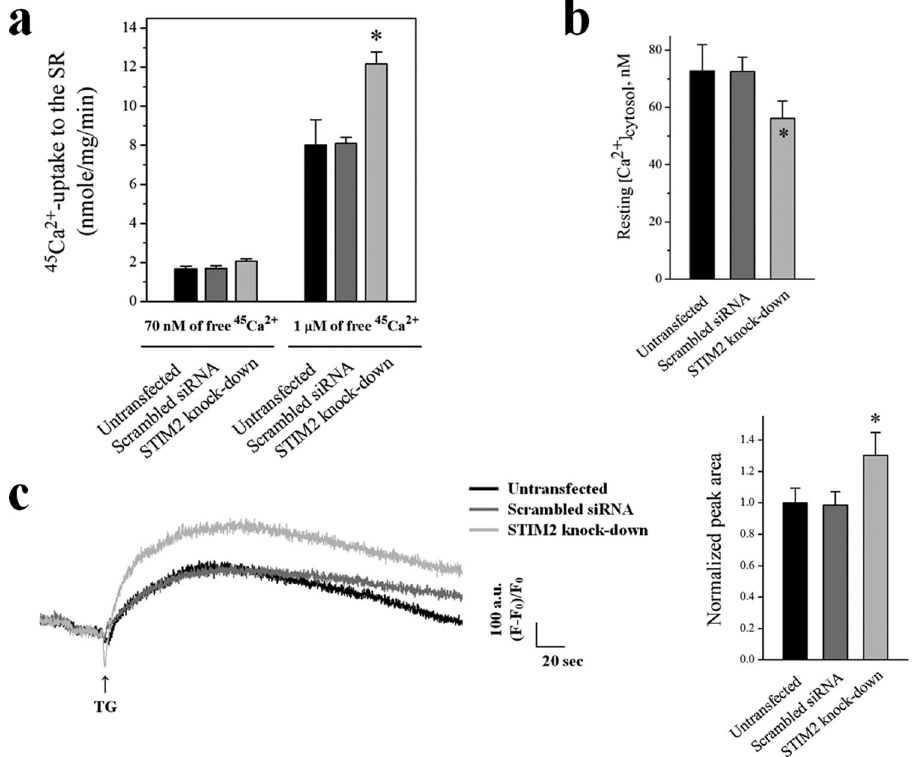
Figure 3. Increases in 45 Ca 2 + -uptake into the SR through SERCA1a and the amount of Ca 2 + in the SR, and a decrease in the cytosolic Ca 2 + level at rest by STIM2-knockdown. ( a ) Oxalate-supported 45 Ca 2 + -uptake into the SR through SERCA1a using the homogenate of the STIM2-knockdown myotubes was measured at 70 nM or 1 μ M of free 45 Ca 2 + . Either an untransfected or a scrambled siRNA-transfected control was used as a negative control. The results are presented as the mean ± S.E. of three independent experiments (Table 3). * Significant difference compared with the untransfected control ( p < 0.05). The STIM2-knockdown myotubes showed a significantly increased 45 Ca 2 + -uptake through SERCA1a only at 1 μ M of free 45 Ca 2 + . ( b ) Cytosolic Ca 2 + level at rest was examined in the STIM2-knockdown myotubes, and histograms are shown for the mean values of each. * Significant difference compared with the untransfected control ( p < 0.05). The values are presented as the mean ± S.E. for the number of myotubes shown in the parentheses of Table 4. Cytosolic Ca 2 + level at rest was decreased by STIM2-knockdown. ( c ) To measure the amount of Ca 2 + in the SR, TG was applied to the STIM2-knockdown myotubes in the absence of extracellular Ca 2 + to avoid extracellular Ca 2 + entry. A representative trace for each group is shown, and the results are summarized as bar graphs in the right-hand panel. * Significant difference compared with the untransfected control ( p < 0.05). The values are presented as the mean ± S.E. for the number of myotubes shown in the parentheses of Table 4. The amount of Ca 2 + in the SR was significantly increased by STIM2-knockdown.